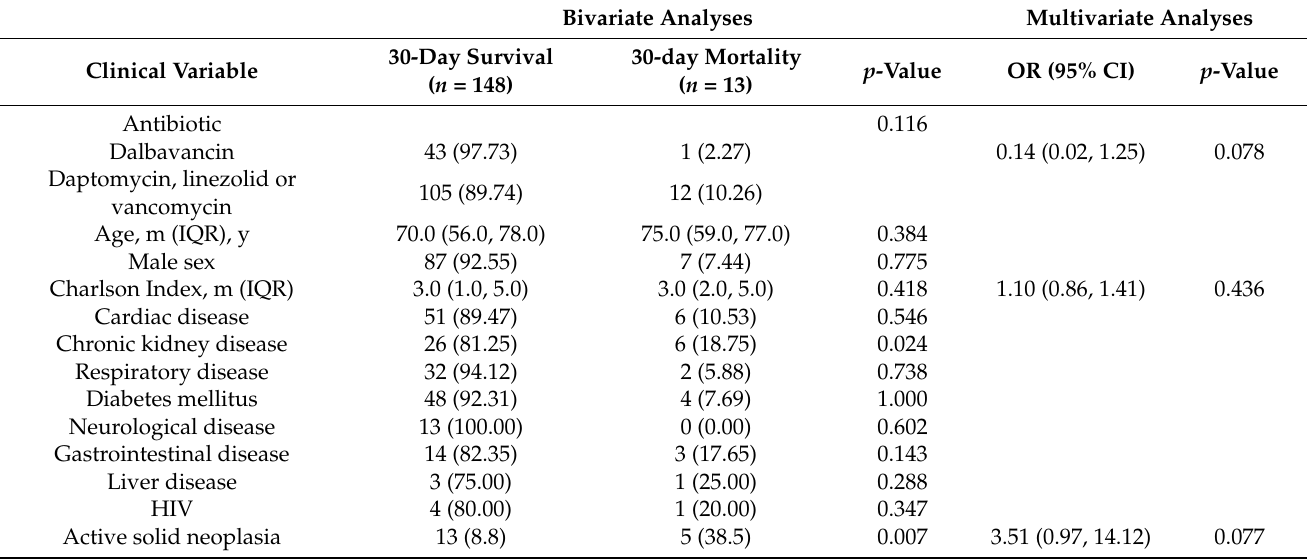
Table 4. Bivariate and multivariate analyses of factors related to 30-day mortality. Bivariate